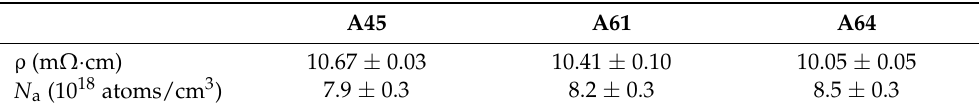
Table A1. Resistivity values (in m Ω · cm), corresponding doping concentration (atoms/cm 3 ) and standard uncertainties determined for A45, A61 and A64 samples.